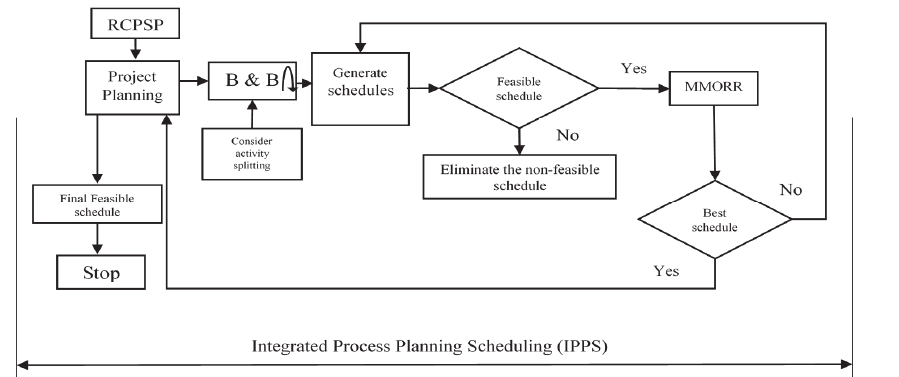
Fig. 2. The proposed model for integration process planning and